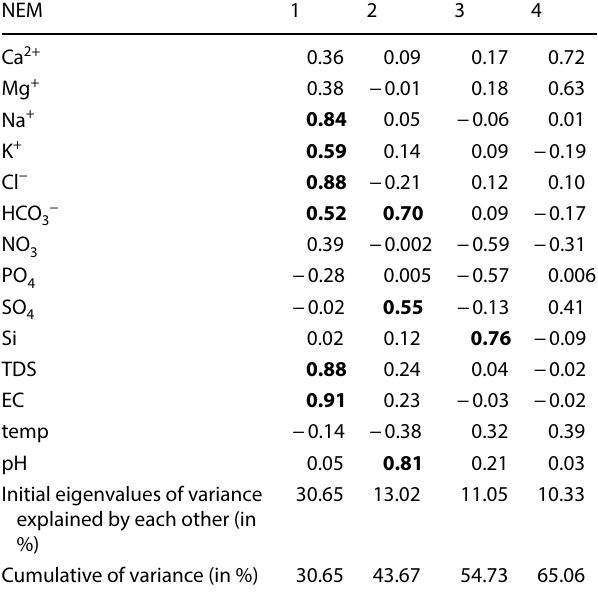
Table 6 Factor scores of GW samples and varimax factor matrix of chemical constituents during NEM (numbers in bold indicates the positive loadings of the parameters in the factor)